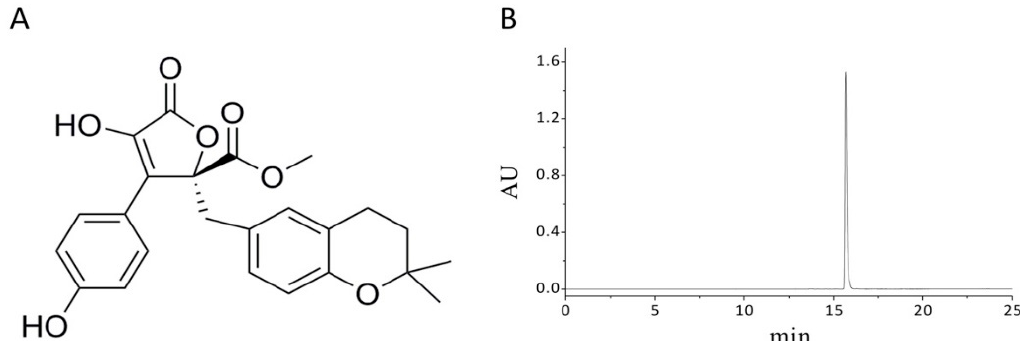
Figure 1. The chemical structure and purity of aspernolide A. ( A ) Chemical structure of aspernolide A; ( B ) HPLC chromatogram of aspernolide A.